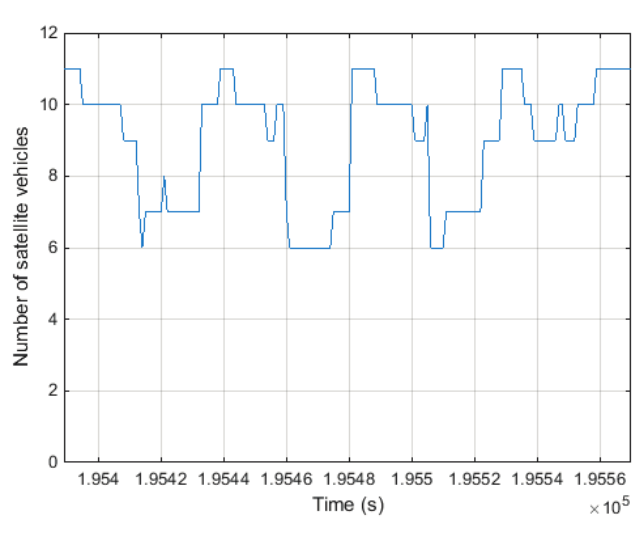
Figure 13. Number of visible satellites.